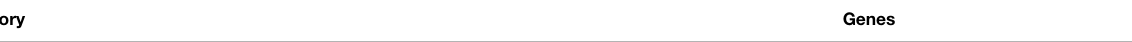
TABLE 6 | Validation of 13 hub genes using GEPIA. Category Genes Genes with differential expression between the CRC and normal tissues ( p < 0.05) Genes without differential expression between the CRC and normal tissues ( p >